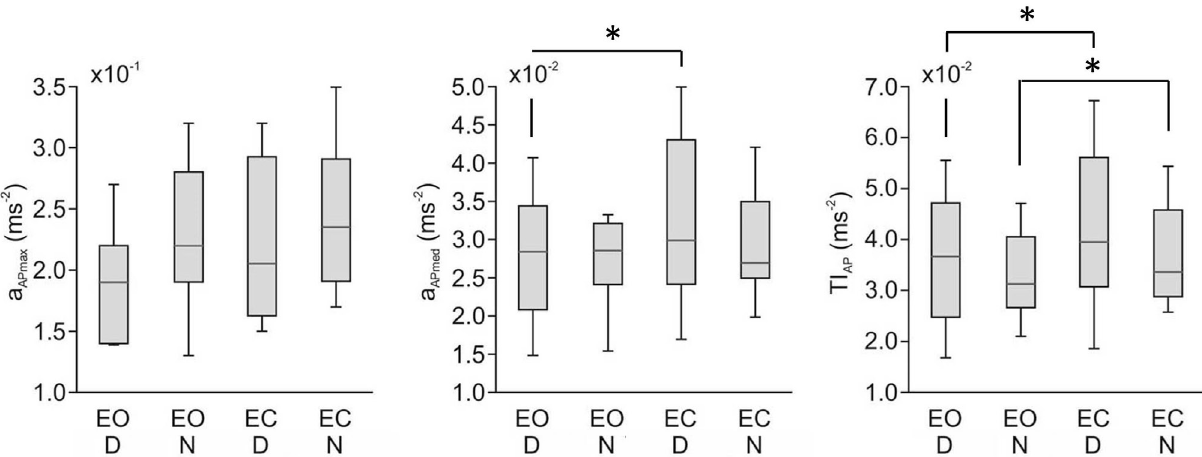
Figure 4. Comparison of maximum (max) and median (med) anterior-posterior accelerations and tremor intensity (TI) of anterior-posterior acceleration of dominant (D) and non-dominant (N) upper arms of subjects standing with eyes open (EO) and eyes closed (EC). *statistically significant difference.